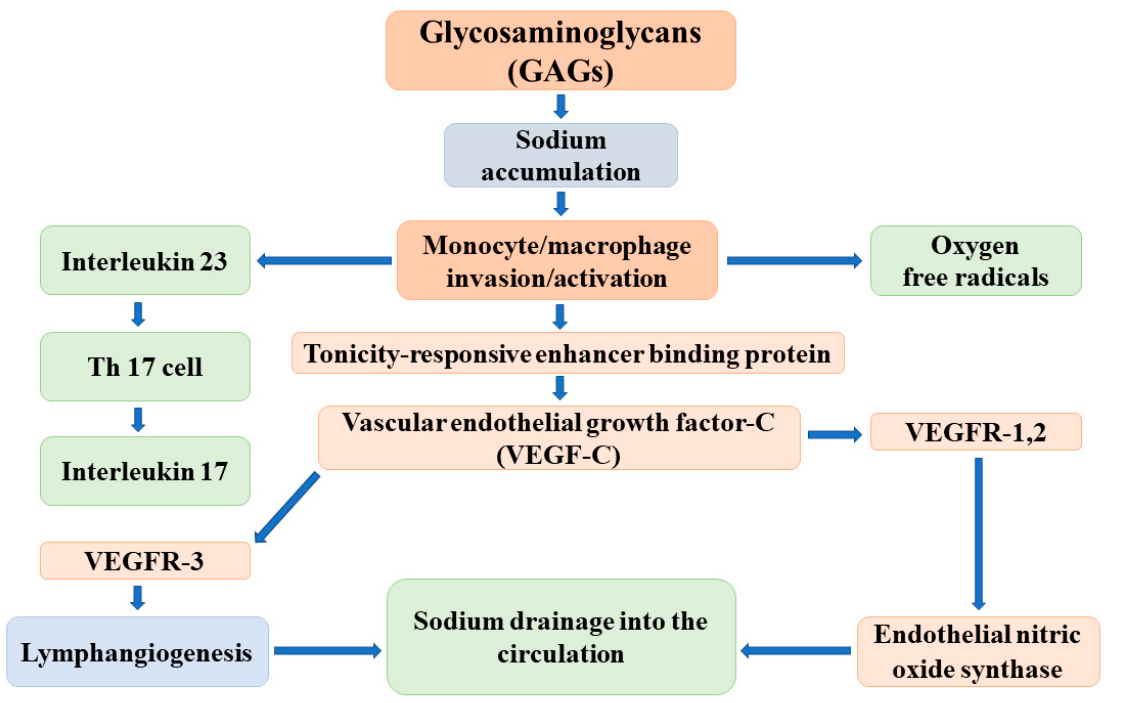
Figure 2. The possible mechanisms of the reversible, nonosmotic sodium storage and release in the skin interstitium.